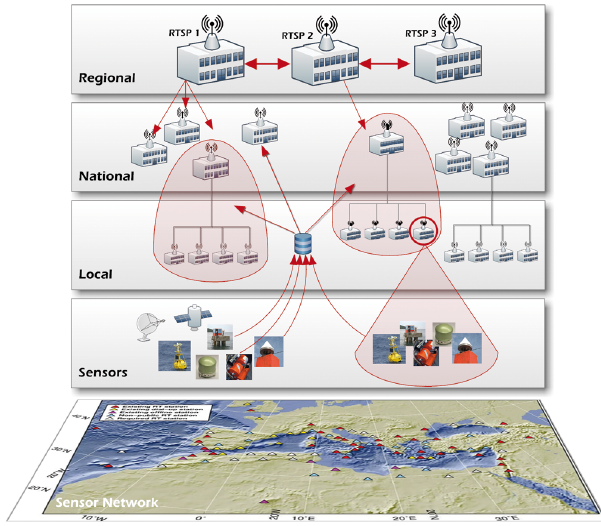
Fig. 8. Architectural levels of a regional tsunami warning